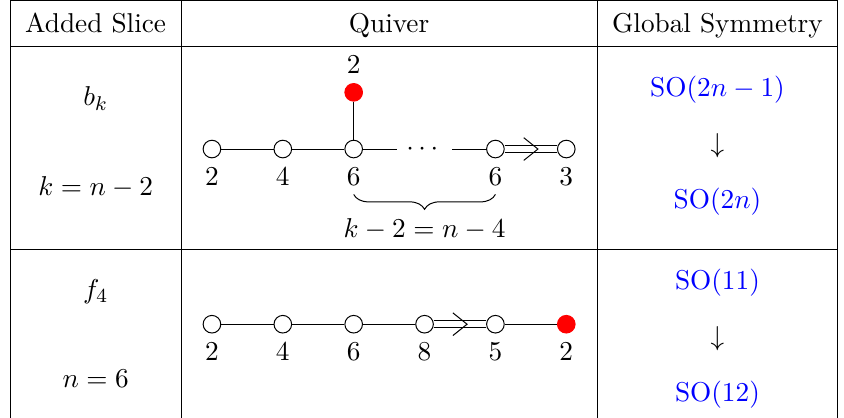
Table 16 . Quivers resulting from adding all possible elementary slices to the existing nodes of n.min D (6.1) to absorb a for n ≥ 3 n